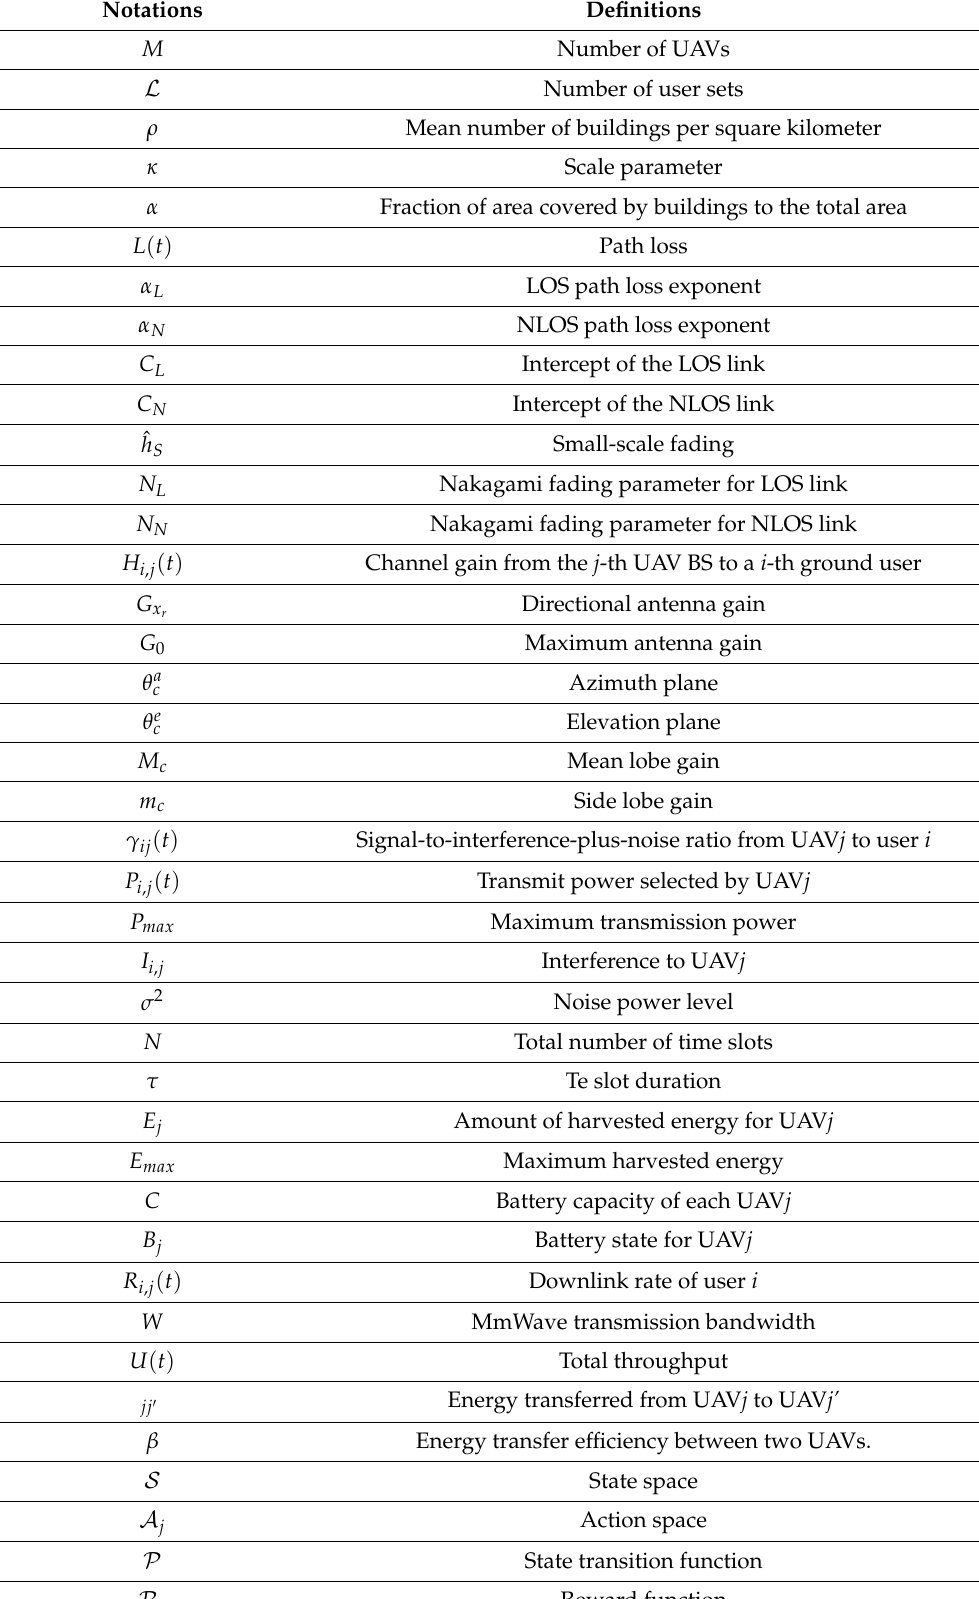
Table 1. List of